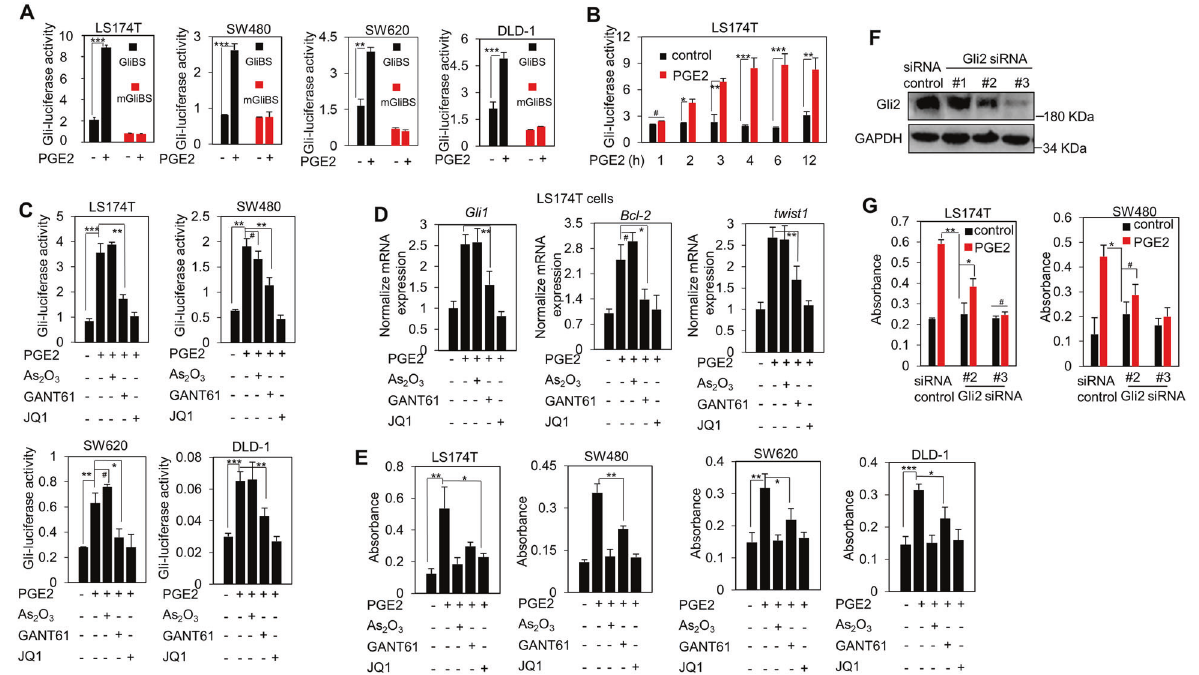
Fig. 1 PGE2 non-canonically promotes the Hh pathway activity in colorectal cancer cells. A , B Luciferase assay for Gli transcriptional activity in colorectal cancer cells with or without PGE2 (1 μ M) stimulation. Cells were transfected with GliBS-Luciferase or mGliBS-Luciferase plasmids plus TK-Renilla, and then treated with PGE2 for 6 h ( A ) or 1 – 12 h ( B ). GliBS is a Gli-responsive reporter, and mGliBS is a Gli-unresponsive reporter. Error bars represent SD ( n = 3). C Luciferase assay for Gli transcriptional activity in colorectal cancer cells subjected to PGE2 with or without Gli inhibitors As 2 O 3 (10 μ M), GANT61 (20 μ M), and JQ1 (1 μ M) for 6 h. Error bars represent SD ( n = 3). D The mRNA levels of Gli target genes in colorectal cancer cells were examined by real-time PCR and normalized to the mRNA level of gusb . Cells were exposed to PGE2 (1 μ M) with or without As 2 O 3 (10 μ M), GANT61 (20 μ M), and JQ1 (1 μ M) for 6 h. Error bars represent SD ( n = 3). E The proliferation of colorectal cancer cells was examined with BrdU assays. Cells were exposed to PGE2 (1 μ M) with or without As 2 O 3 (10 μ M), GANT61 (20 μ M), and JQ1 (1 μ M). Error bars represent SD (n = 3). F Immunoblot analysis of Gli2 expression in LS174T cells transfected with Gli2 siRNA. G The proliferation of colorectal cancer cells LS174T and SW480 was examined with BrdU assays. The cells were transfected with Gli2 siRNA followed by treatment with or without PGE2 (1 μ M). Error bars represent SD ( n =